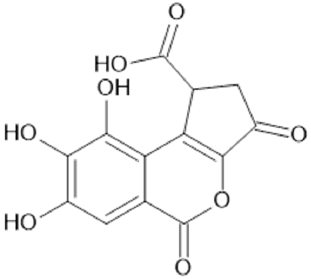
Plants 2022 , 11 , x FOR PEER REVIEW Figure 14. Chemical structure of compound 69 (MW = 292). Figure 14. Chemical structure of compound 69 (MW = 292).